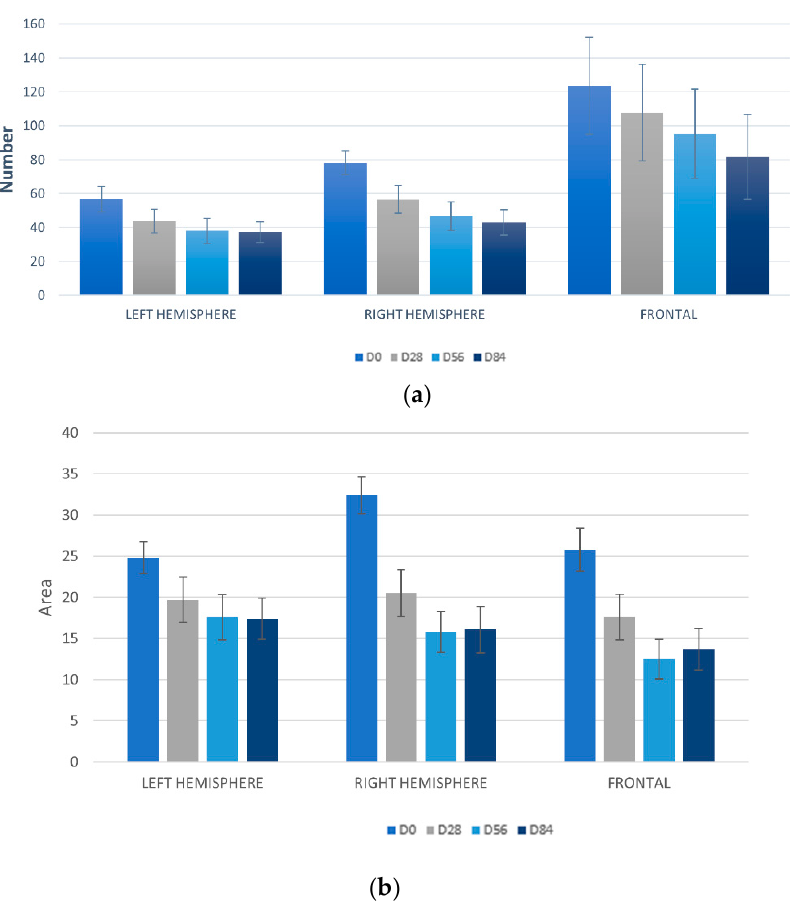
Figure 6. Measurements of UV spots in different facial regions (left and right hemisphere and frontal area) at different times (D0, D28, D56 and D84). ( a ) Number of UV spots in evaluated areas; ( b ) Surface of UV spots in evaluated areas.